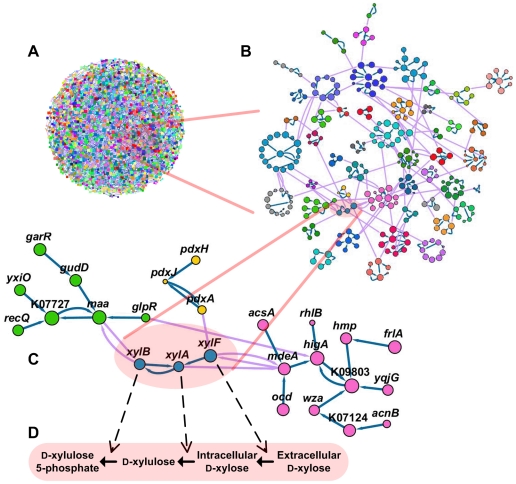
MRS of gene associations.(A–C) Large-scale to small-scale overviews of the MRS. A part of the whole MRS in (A) is magnified in (B) to reveal its clear modular structure. Circles represent genes, and each gene i is arrowed to gene j having the largest |wij| with wij>0 (dark arrow) or wij<0 (light arrow). Size of each circle corresponds to Sip of the gene, and circles are colored the same if linked via wij>0. In (B) and (C), different groups of genes linked via wij>0 are shown to be seamlessly connected by links of wij<0. In (C), gene names or KEGG identifiers appear for relevant circles. (D) Transport and biochemical conversions of xylose catalyzed by the proteins from genes in (C).